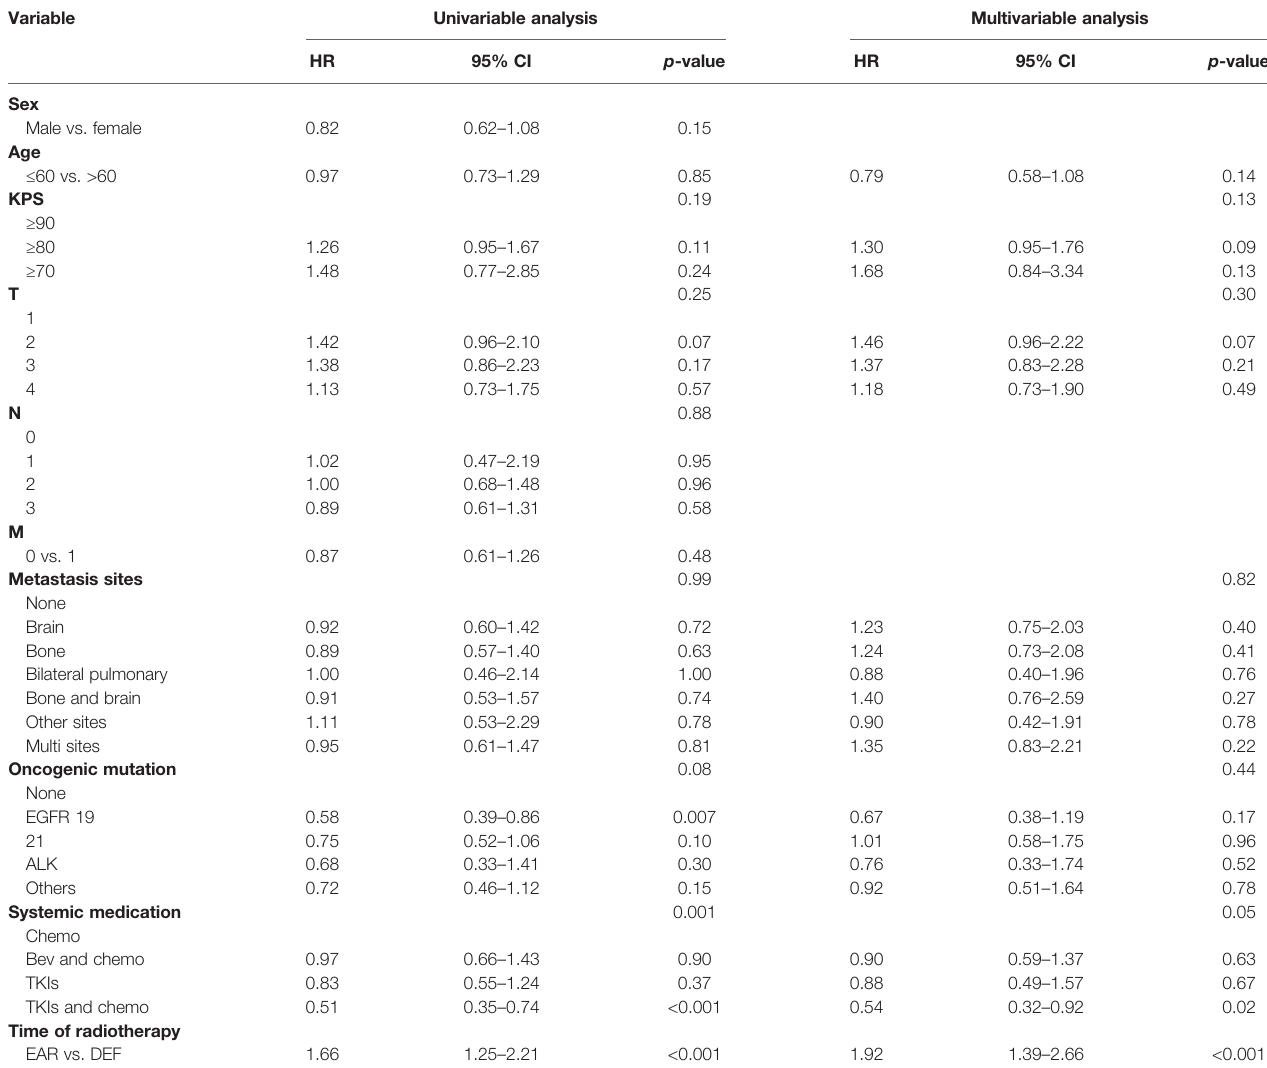
TABLE 2 | Univariable and multivariable analyses of covariables associated with PFS. Variable Univariable analysis Multivariable